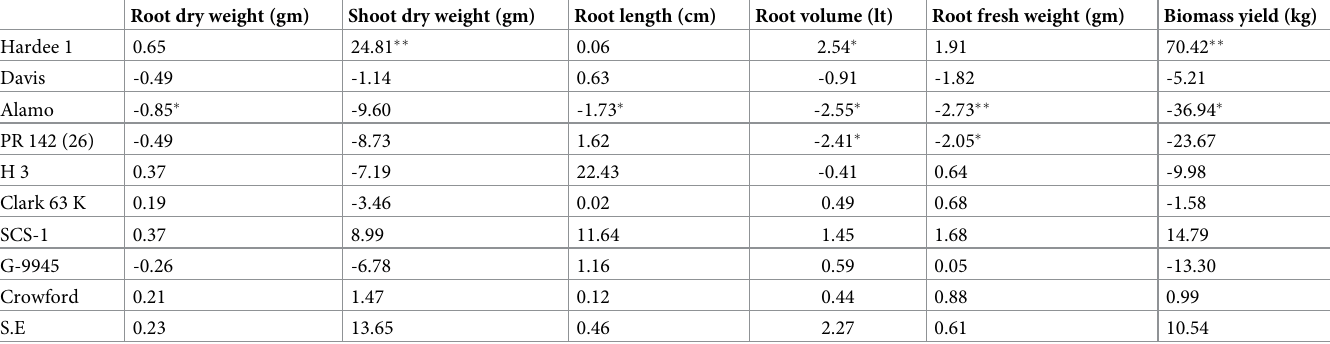
Table 4. General combining ability effects of root traits of nine soybean parental genotypes evaluated under low P conditions in Ethiopia. Root dry weight